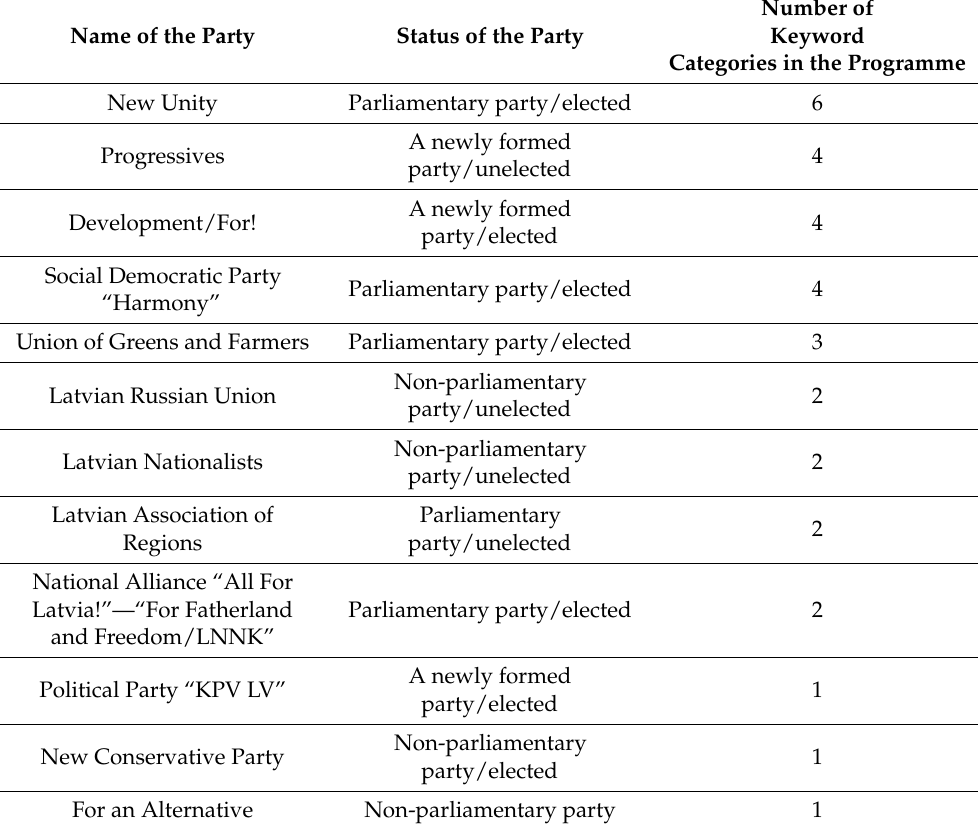
Table 7. Parties’ ranking according to the share of climate-related keywords in the programmes.